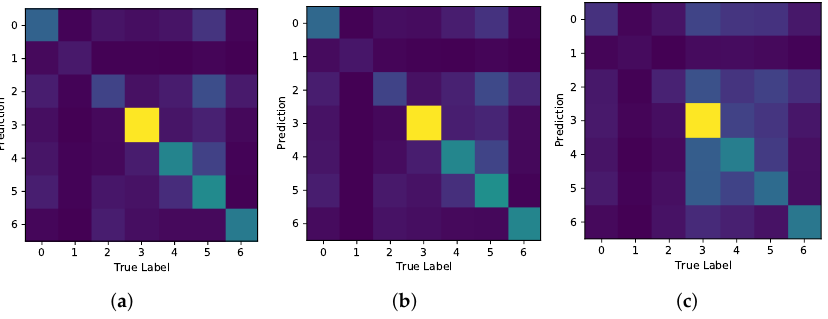
Figure 18. Model A Confusion Matrices. ( a ) E1. ( b ) E2. ( c ) E3.